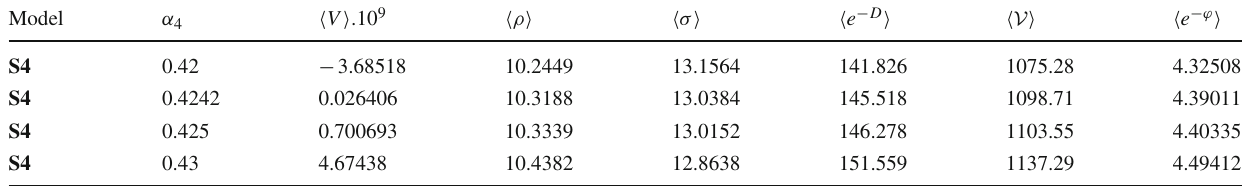
Table 5 The numerical samplings for AdS and dS (via crossing the Minkowskian) solutions for a range of values for the α 4 parameter. The flux parameters for model S4 are: e 1 = − 100 , e 0 = 0 , m 1 = 0 , m 0 = 1 , H 0 = 50 , H 1 = 1. The plots showing the uplift are presented in Fig.1 Model